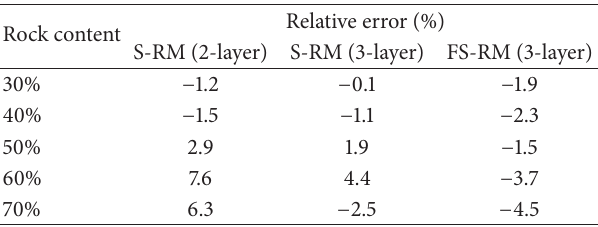
Figure 11: Comparison between the values calculated by the soil- rock mixture model and experimental values at normal temperature condition. Table 5: Relative error chart between model calculation values and the measured test